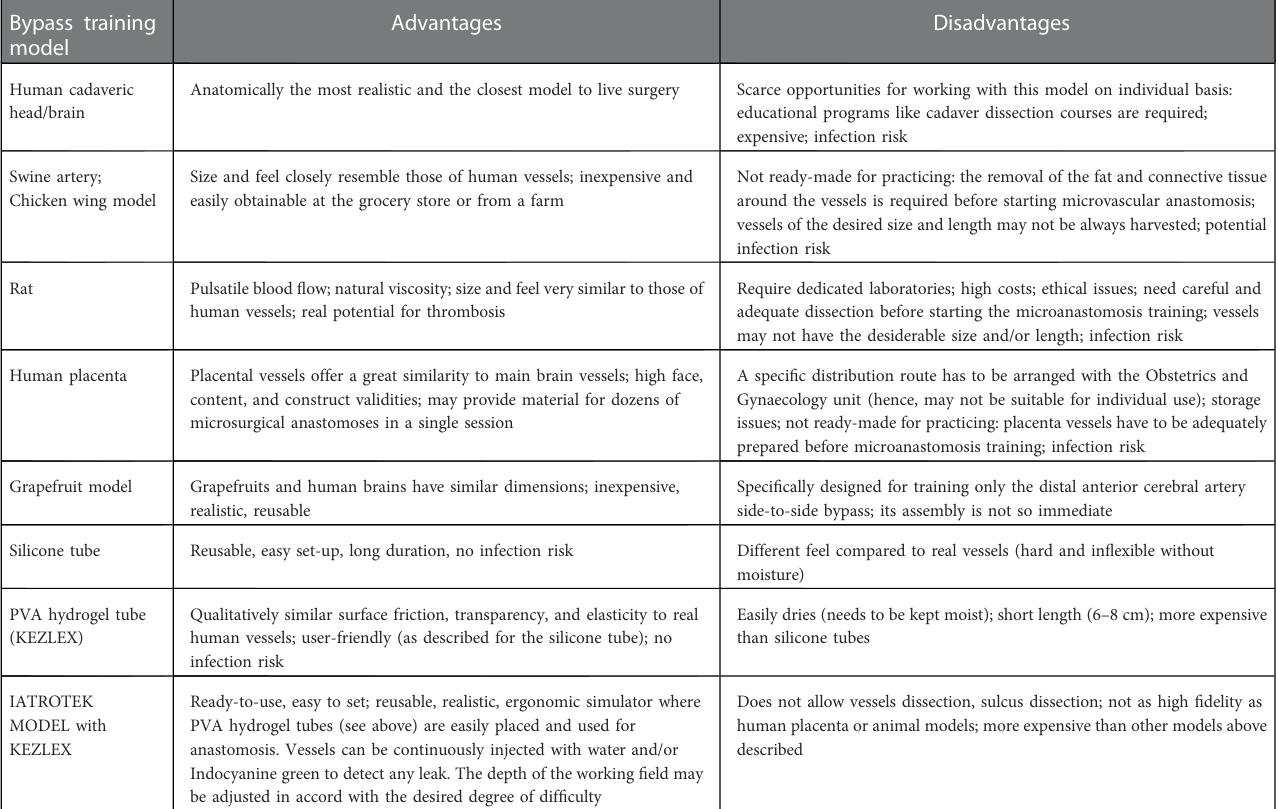
TABLE 4 Summary of the advantages and disadvantages of available bypass training models for practicing microvascular anastomosis.